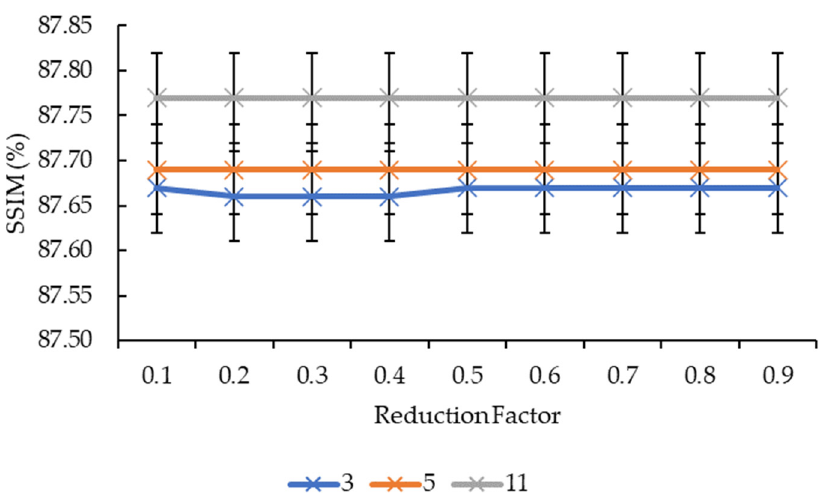
Figure 4. Graph of SSIM against reduction factor.